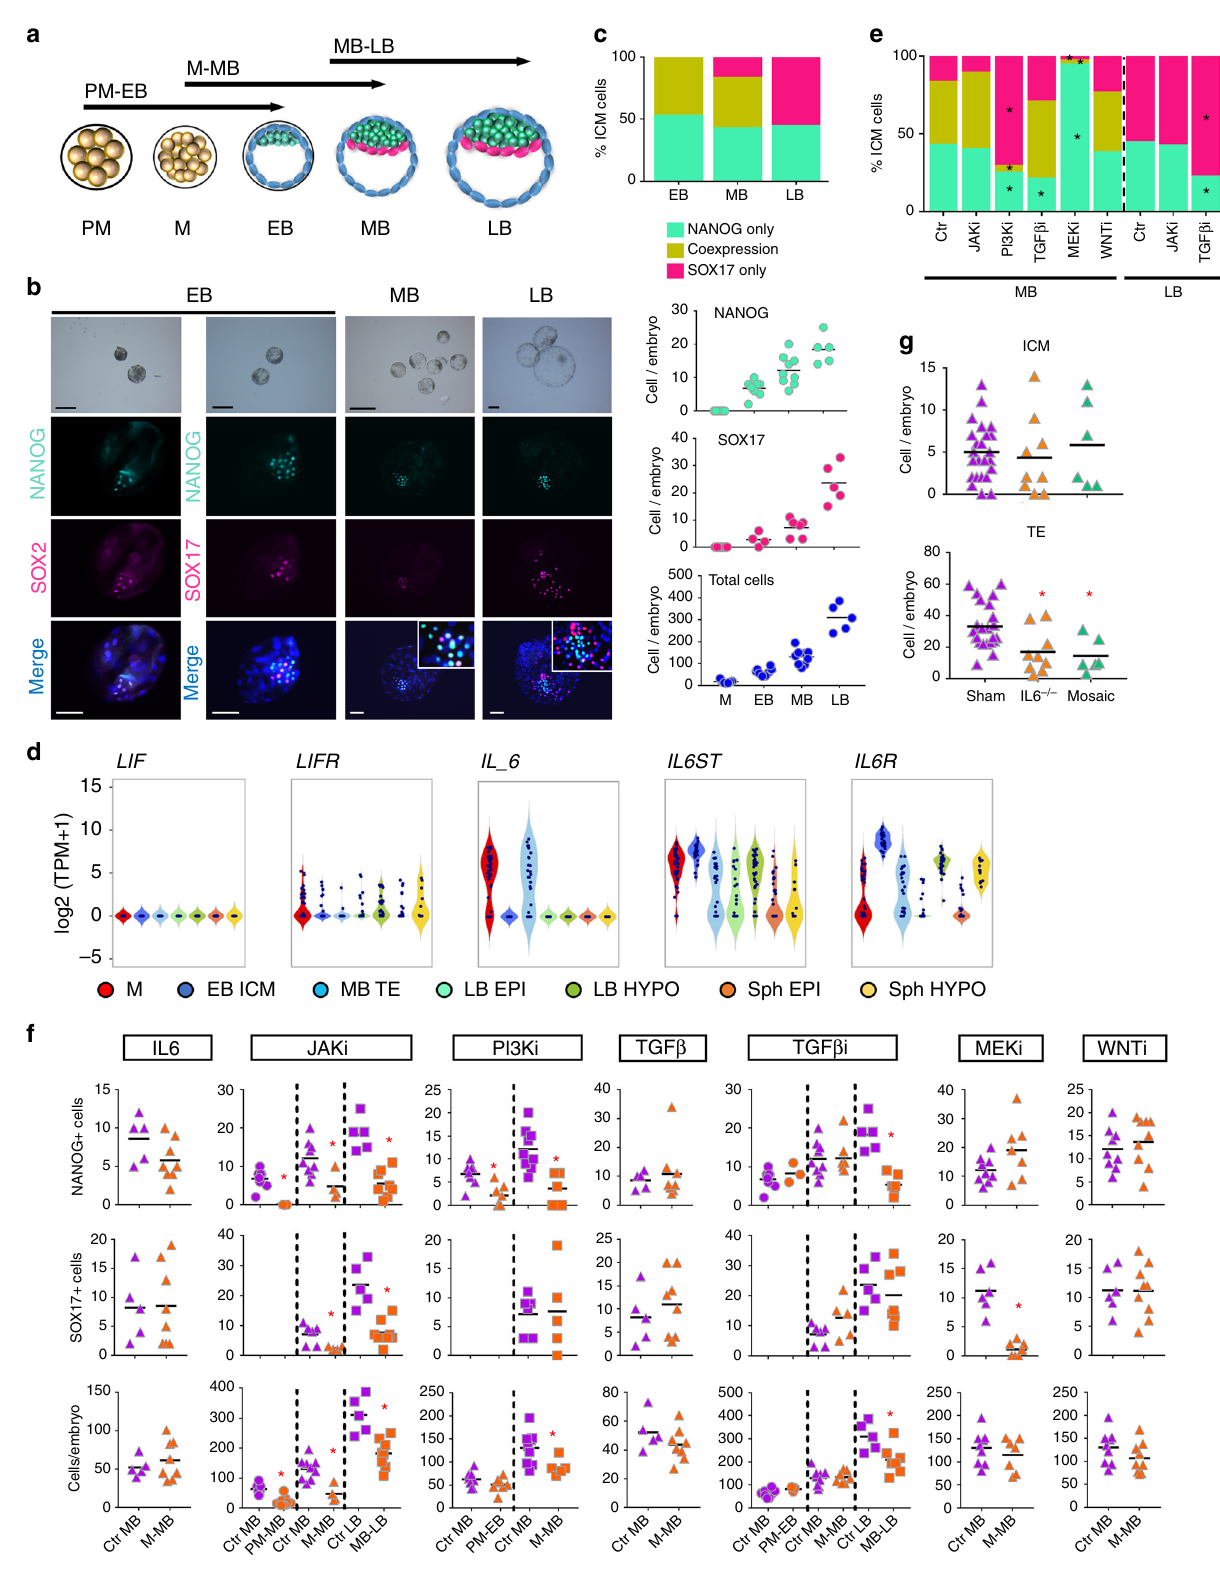
Lastly, since regulation of the canonical WNT pathway was a signi fi cantly upregulated GO term in the ICM, we cultured pig embryos with the tested WNT inhibitor IWP2. No reduction in